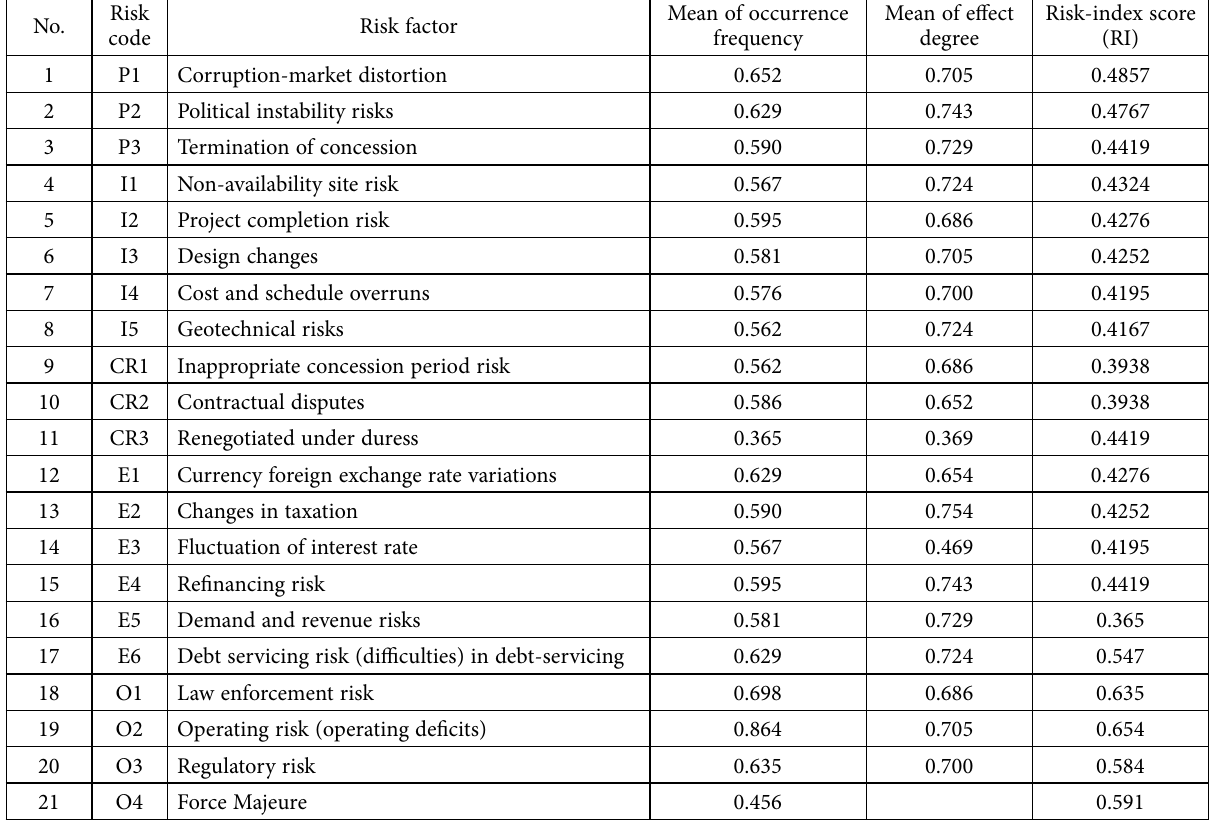
Table 1. Principal risks of PPPs projects in